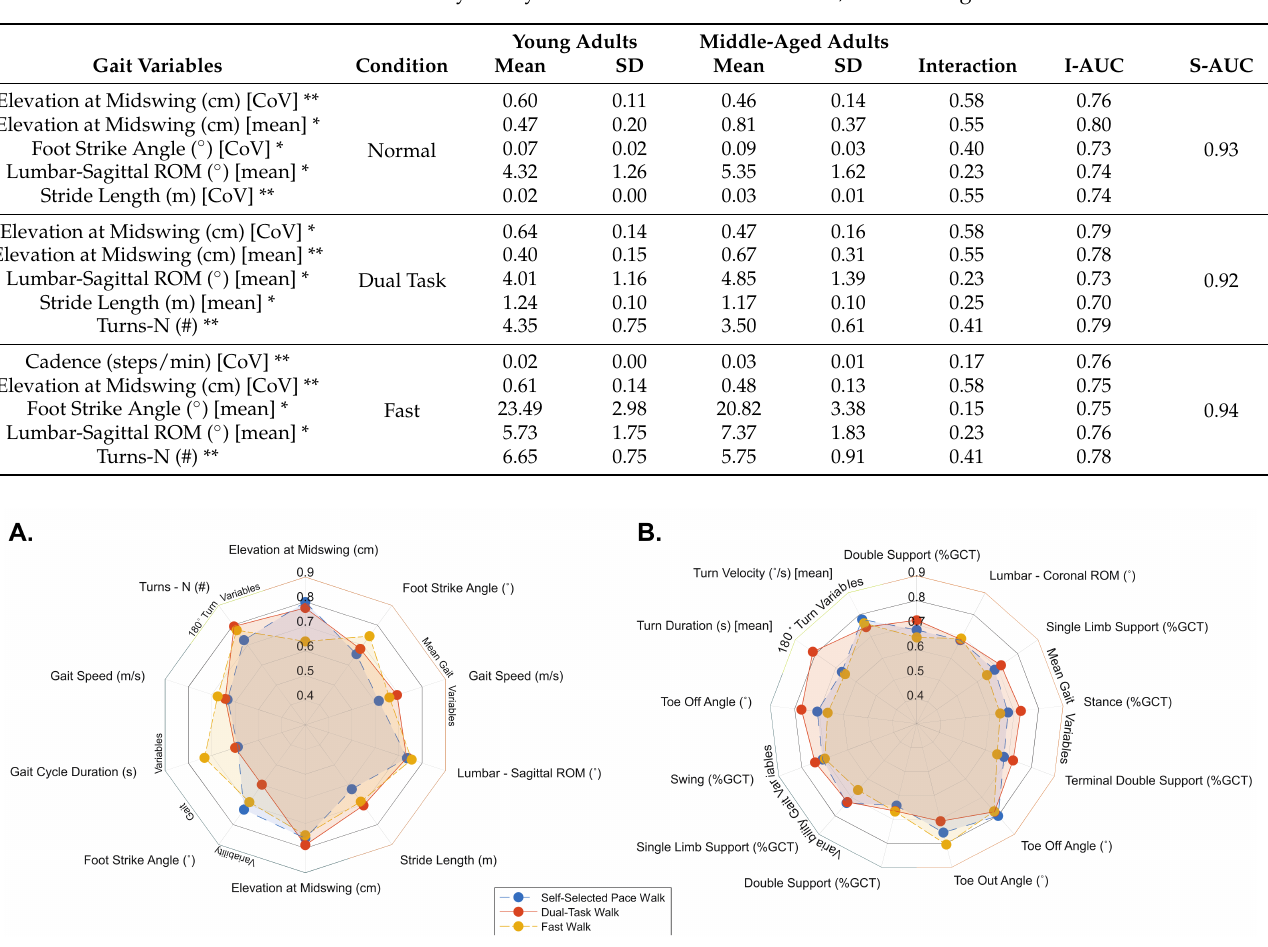
Figure 2. Spider plot indicating the variables that were consistently observed in the top 20 AUC producing variables for each walking condition. ( A ) Represents the 10 AUC producing variables that were observed in all three walking conditions between YAs and MAAs. ( B ) Represents the 13 AUC producing variables that were observed in all three walking conditions between MAAs and